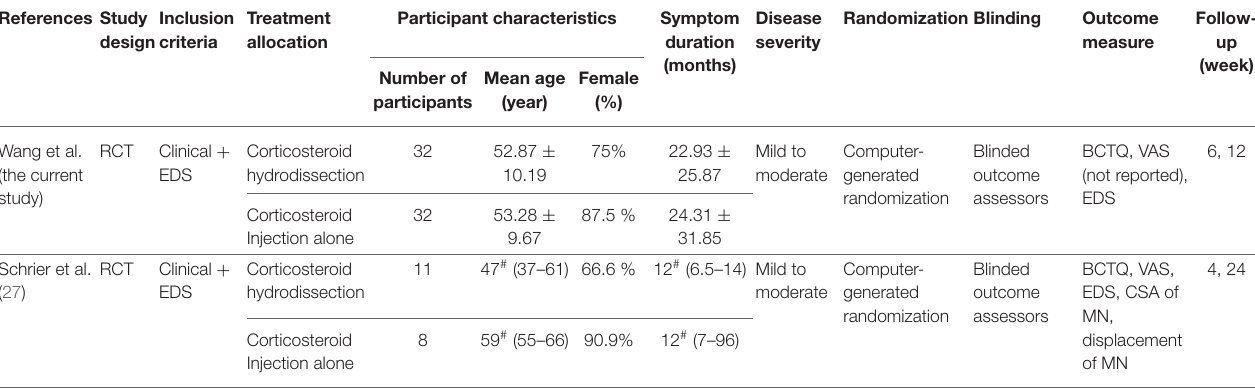
TABLE 3 | Comparison of the demographic characteristics between the current study and another randomized controlled trial with similar methodology. References Study Inclusion design